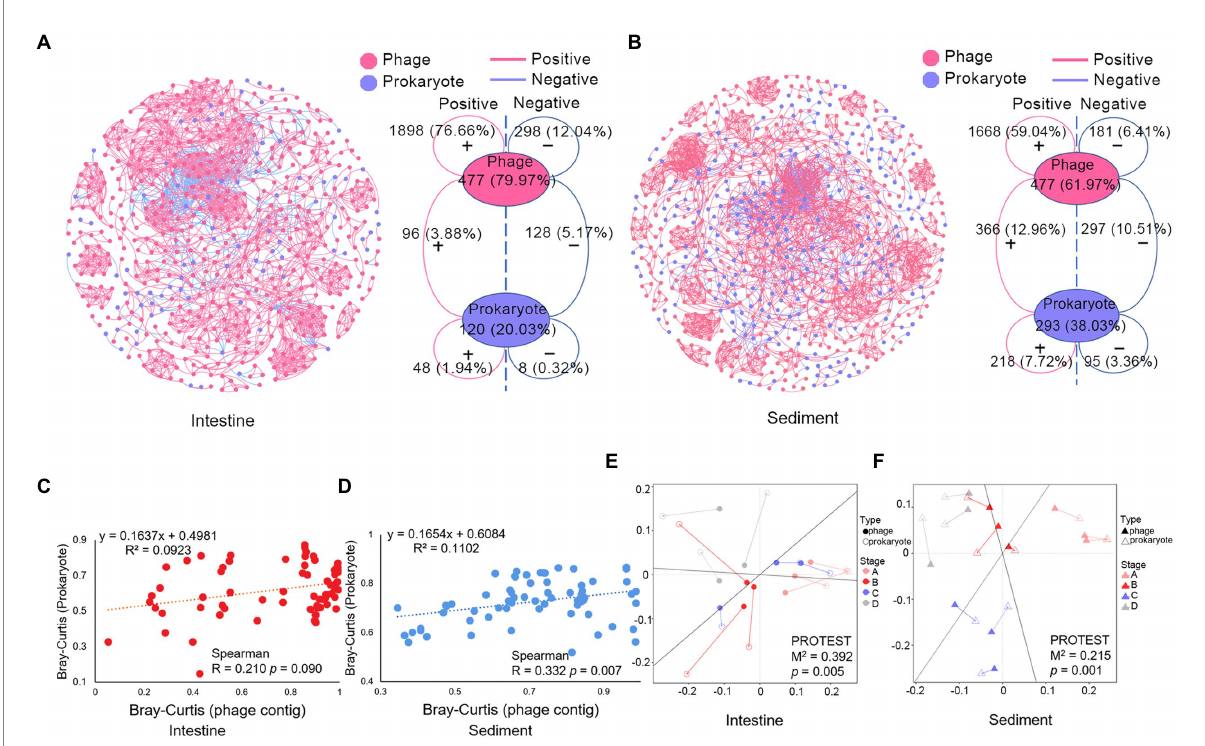
FIGURE 3 Correlations analysis of the microbial community in shrimp intestine and sediment. Co-occurrence network of (A) shrimp intestine microbial community, (B) sediment microbial community, and topological information of the microbial community co-occurrence network. The positive or negative linkages of the association networks were based on positive or negative Spearman’s correlations between any pairs of nodes. Phage contigs (red) and prokaryotic ASVs (blue) are network nodes, the red line means positive correlations, and the blue line means negative correlations. Plot showed the relationship between the Bray-Curtis distance of phage (contigs level) and prokaryotic (ASV level) community in (C) shrimp intestine and (D) sediment, and the Spearman correlation coefficient is indicated. Procrustes analysis depicting the correlation between phage community (solid graphics) and prokaryotic community (hollow graphics) on the basis of Bray–Curtis dissimilarity metrics in (E) shrimp intestine and (F)